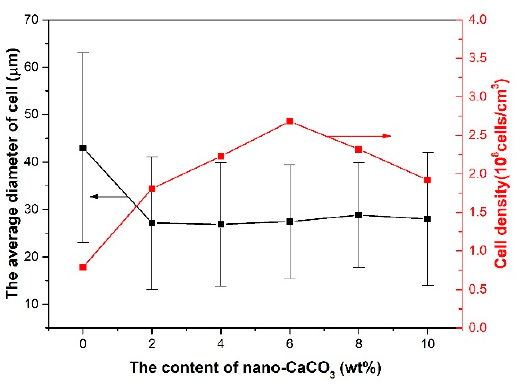
Figure 16. The average cell diameter and cell density of the transition layer of the vertical sections with different contents of nano-CaCO 3 .